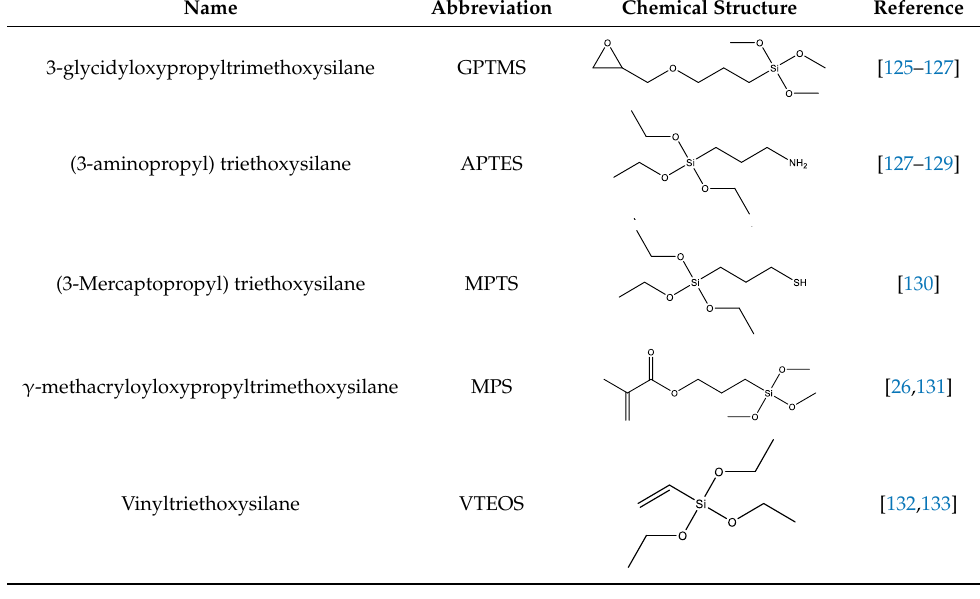
Table 1. Silane-coupling agents used for grafting SNs.